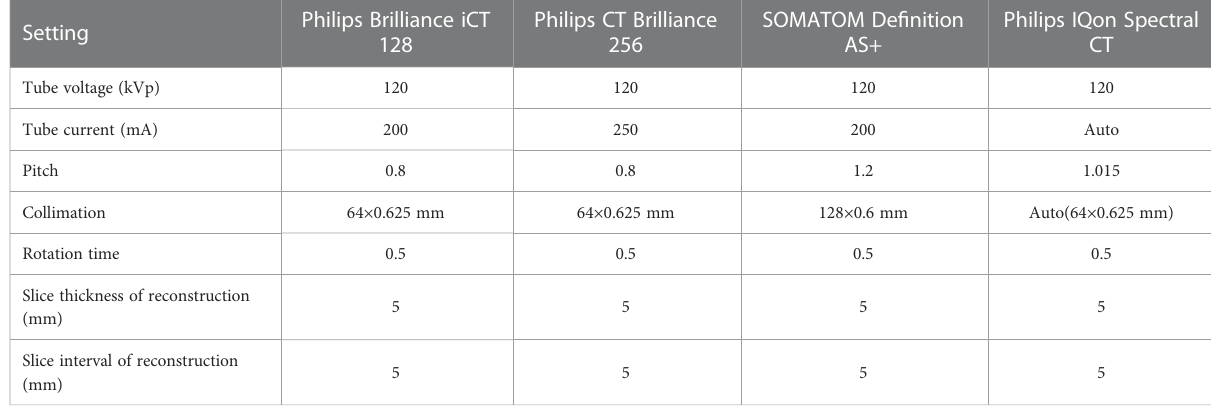
TABLE 1 The detailed scan and reconstruction parameters.